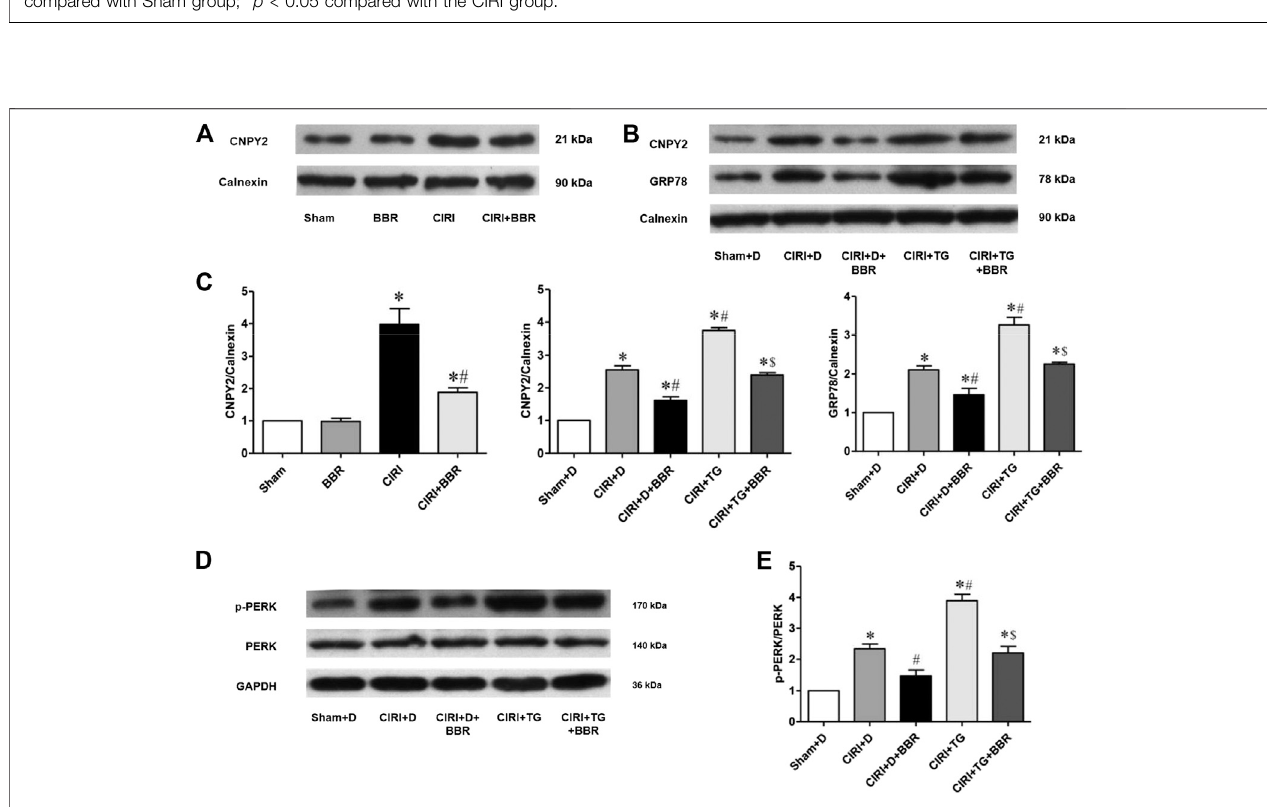
FIGURE 6 | BBR attenuates neuronal apoptosis by inhibiting CNPY2-ERS in ischemic penumbra. The CNPY2-ERS apoptotic signaling proteins CNPY2 (A,B) , GRP78 (B) , and p-PERK/PERK (D) , from cortical ischemic penumbra were determined by Western blot. The results were normalized to the percentage of Calnexin or GAPDH expression. (C,E) , Bar graph showing the statistical comparison of CNPY2, GRP78 and p-PERK/PERK protein levels across groups. n (cid:2) 6. Data are shown as the mean ± SEM. * p < 0.05 compared with the Sham group or Sham + D group; # p < 0.05 compared with the CIRI group or CIRI + D group; $ p < 0.05 compared with the CIRI + TG